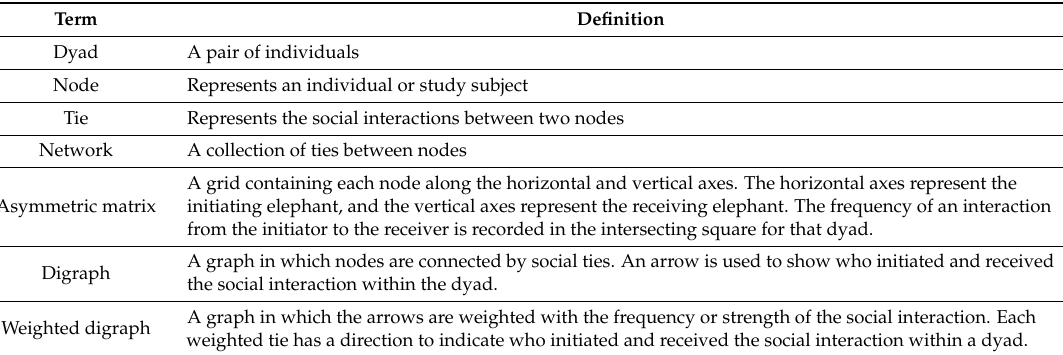
Table 3. Definitions of the terms used in the social network analysis based upon Coleing [29], Wasserman & Faust [35], and Wey et al.